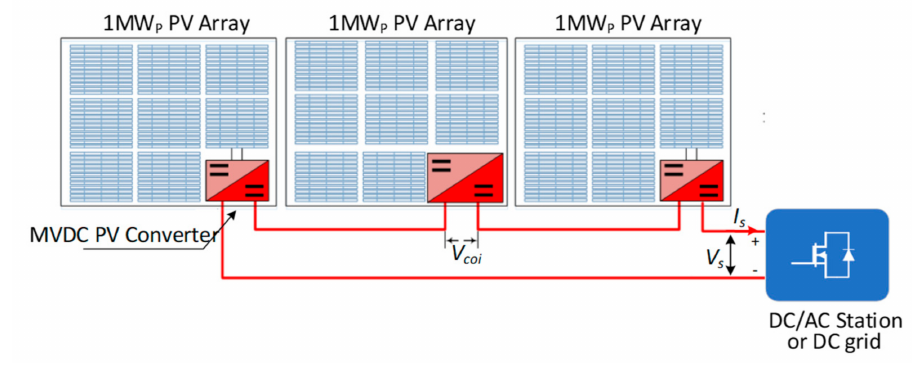
Figure 1. Series PV MVDC